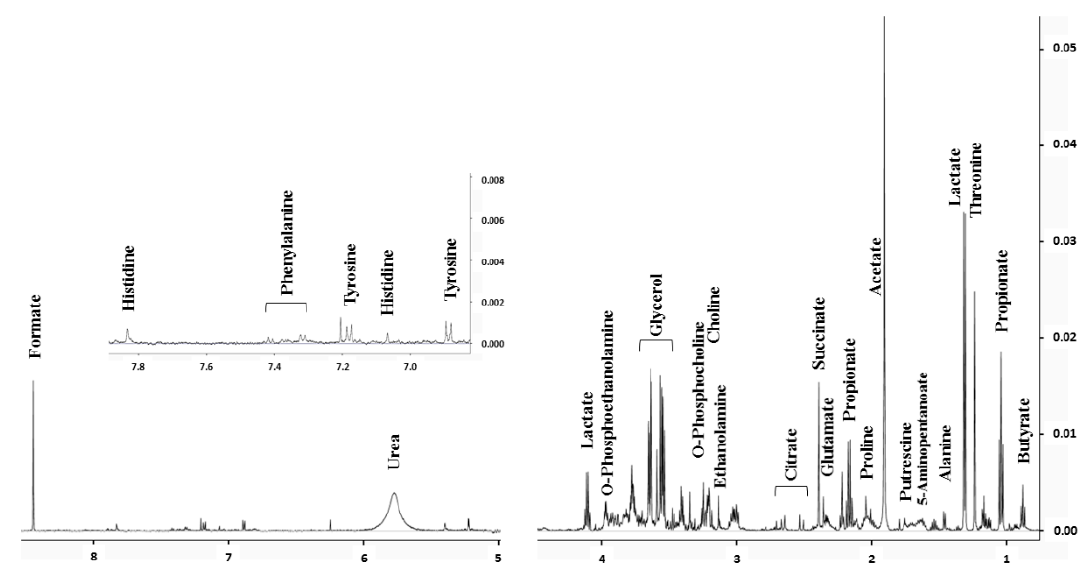
Figure 1. Nuclear magnetic resonance (NMR) spectrum of a saliva sample with the assignment of major metabolites. Table 2. The average concentrations (µM) with relative standard deviations of saliva metabolites in pre-game samples as determined by 1 H NMR.